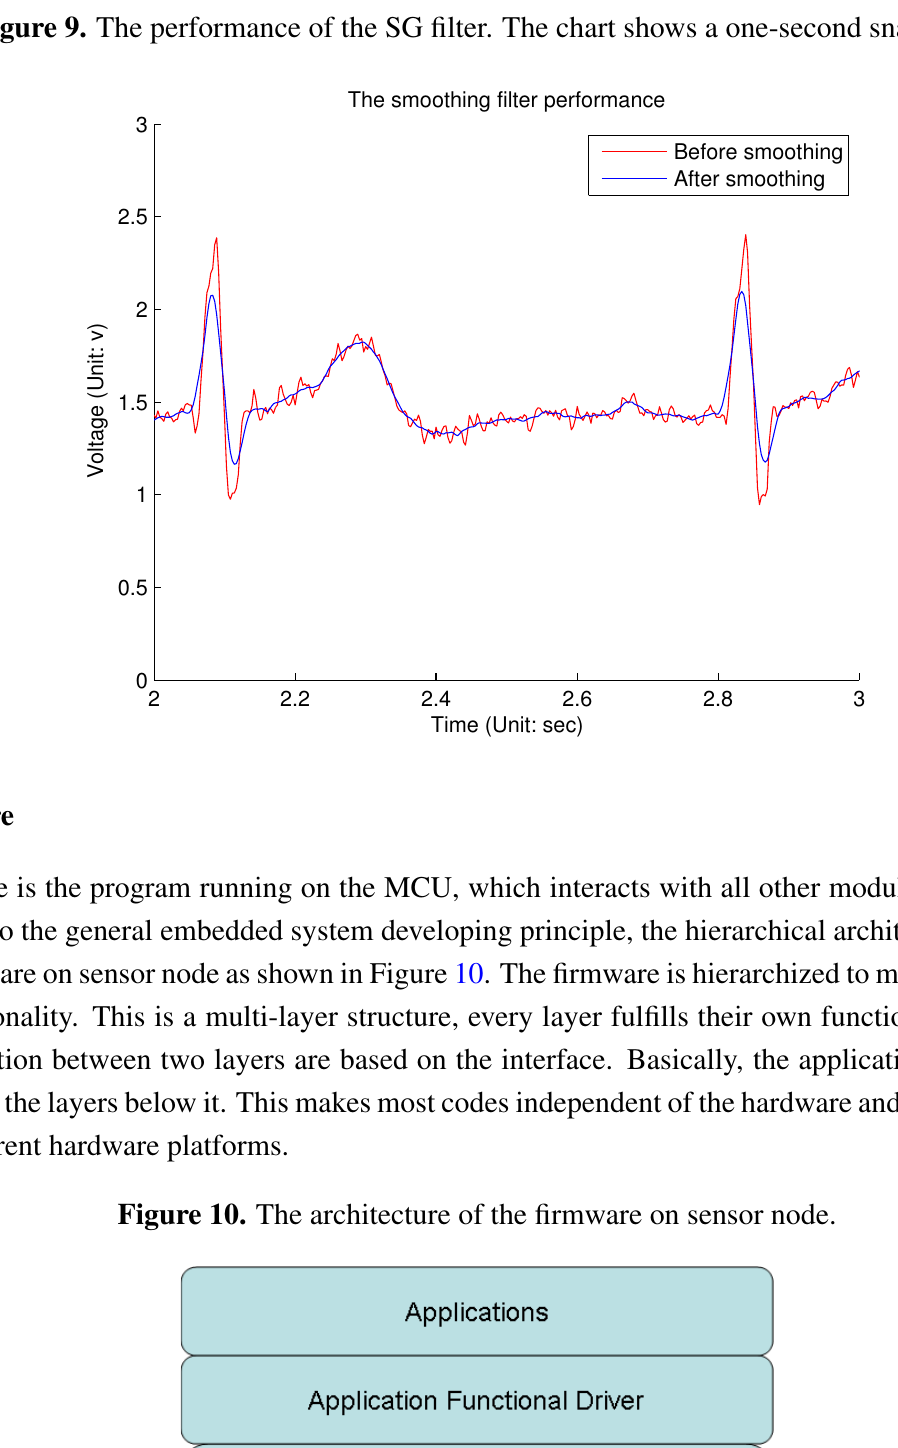
Figure 9. The performance of the SG filter. The chart shows a one-second snapshot.